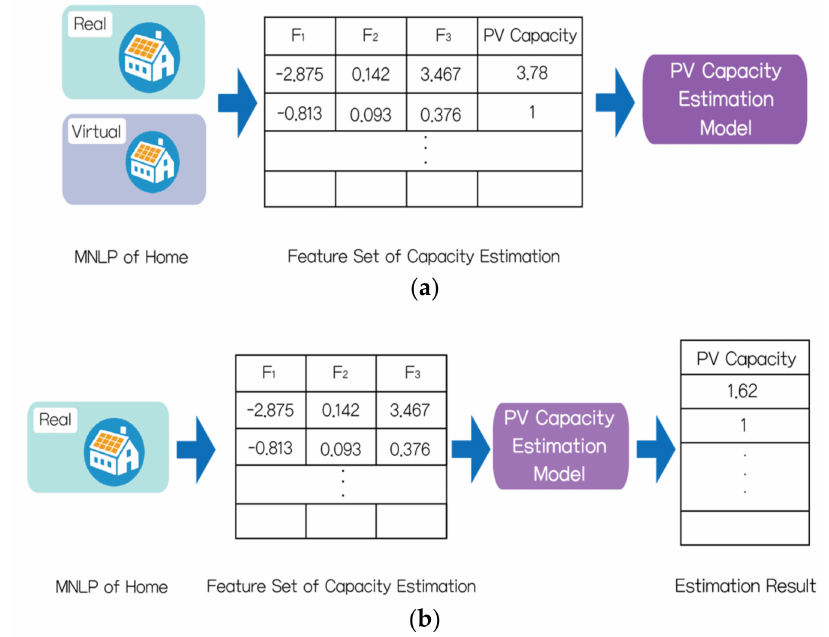
Figure 6. Process of PV capacity estimation ( a ) training ( b )